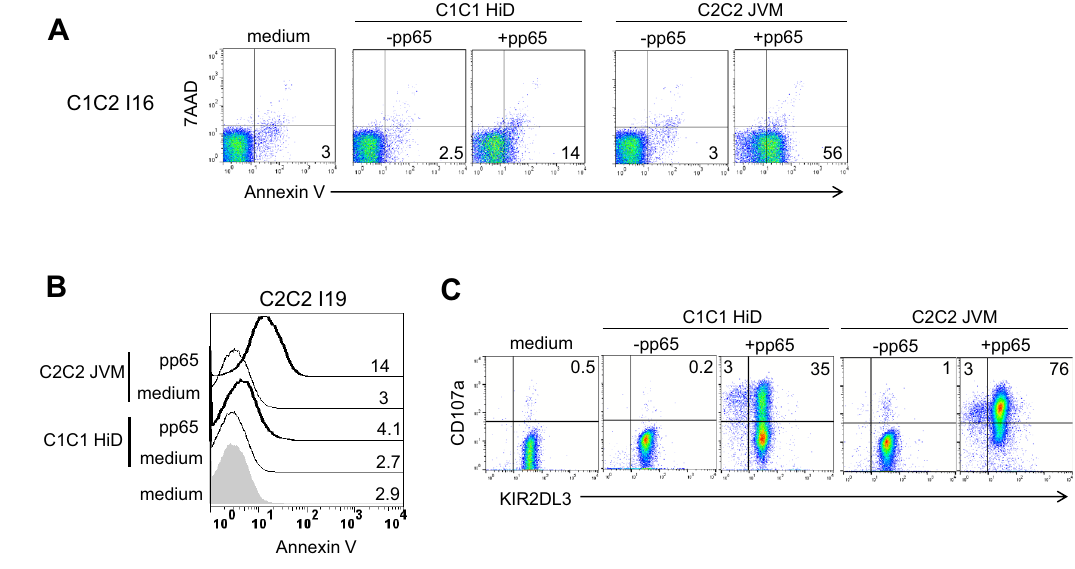
Figure 6. KIR2DL3 inhibits T lymphocyte apoptosis. (A) Density plots illustrating apoptotic HLA-A2-pp65 specific KIR2DL2/3 + T lymphocytes as annexin V + 7AAD − after 3 h incubation alone or in presence of